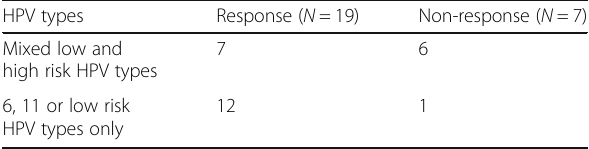
Table 2 HPV types and SR-T100 response in condyloma( N =